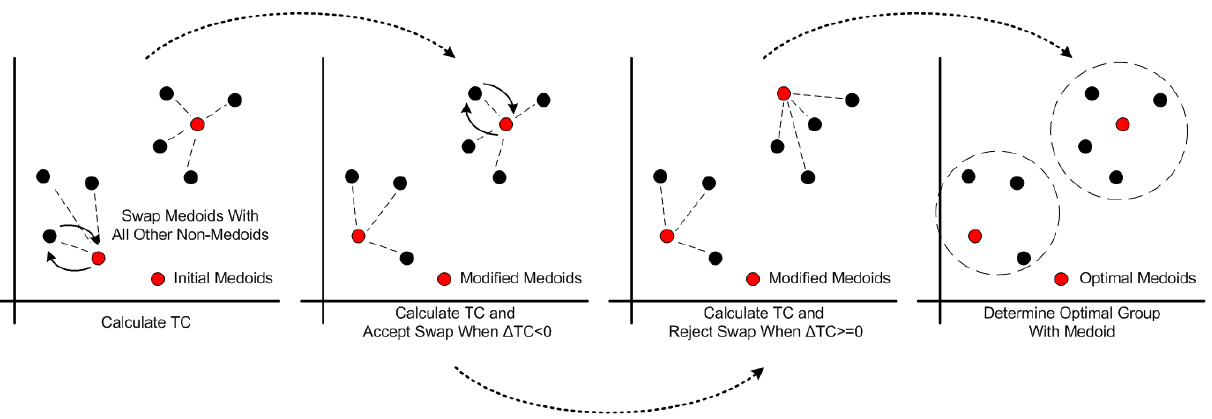
Figure 1. The swap test for the generators in the set M and the non-medoid set.